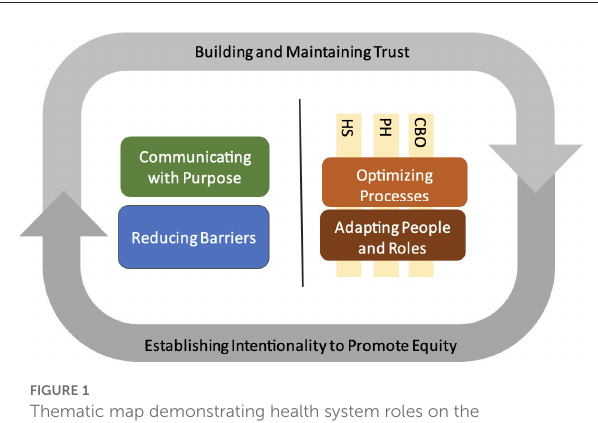
FIGURE1 Thematic map demonstrating health system roles on the inward-facing (right of gray line) and outward-facing (left of gray line) aspects of healthcare delivery during the COVID-19 pandemic, enveloped by trust and intentionality. CBO, community-based organization; PH, public health; HS, health